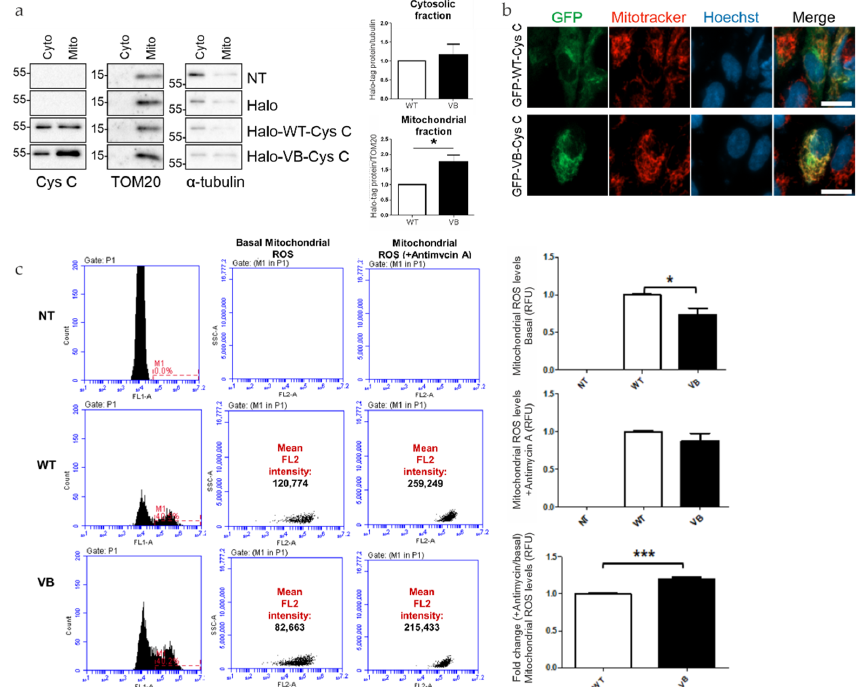
Figure 4. Analysis of mitochondrial association of variant B cystatin C and effects on mitochondrial reactive oxygen species (ROS) generation. ( a ) Immunoblot analysis of mitochondrial and cytoplasmic fractions of ARPE-19 cells expressing WT or variant B cystatin C Halo-tag fusion proteins. Blots were immunostained with antibodies against mitochondrial (TOM20) and cytoplasmic ( α -tubulin) markers in addition to cystatin C. Blots shown are representative of three separate experiments. Graphs show normalized protein expression of Halo-tag fusion proteins in cytosolic and enriched mitochondrial fractions. ( b ) WT and variant B cystatin C EGFP fusion constructs were expressed in ARPE-19, followed by mitochondrial staining using Mitotracker Red FM dye and live cell analysis by fluorescence microscopy using a Zeiss Apotome microscope. Scale bars, 20 µm. ( c ) Mitochondrial ROS detection flow cytometry analysis in ARPE-19 cells transfected with WT and variant B cystatin EGFP fusion constructs (+/ − antimycin A). After P1 gating was performed to exclude dead cells and debris (not shown), M1 (green channel) histograms were used to measure transfection efficiency (left of image). The M1 population was then selected to measure red intensity (FL2) as shown by plots (middle and right). Graphs show red fluorescence intensity (FL2 channel) in the transfected (green population; FL1 channel) cell population for basal mitochondrial ROS production (+/ − antimycin A) and fold change between antimycin A treated cells/non-treated cells for each condition (arbitrary units ± S.E.M. minimum of n = 3; Student’s t test * p ≤ 0.05, *** p ≤ 0.001 ).